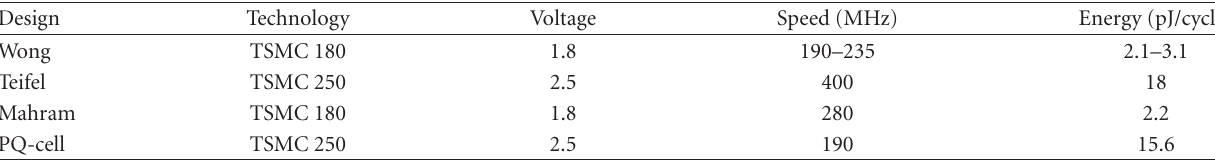
Table 2: Speed and energy consumption of various asynchronous cell